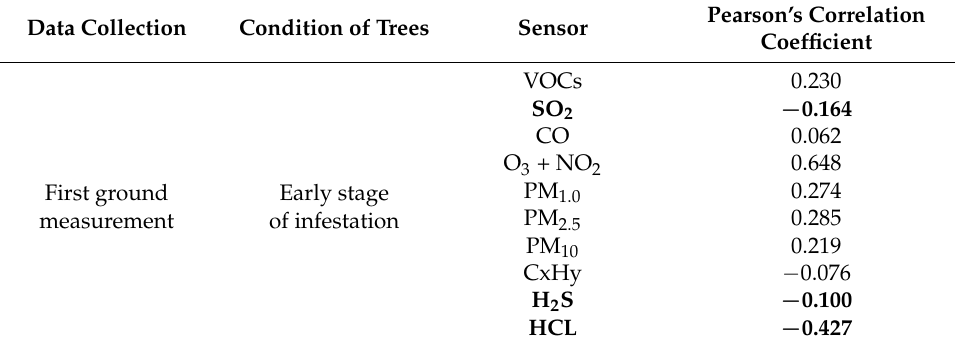
Table 3. Pearson’s correlation coefficient results of data first and second ground collection for early-stage infestation